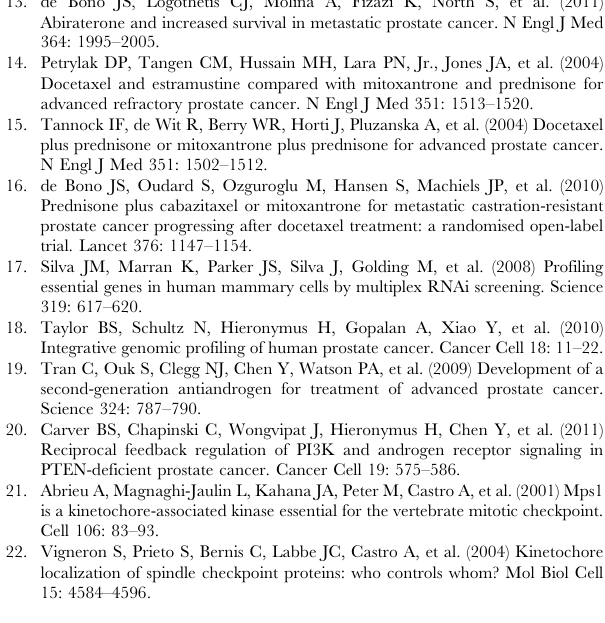
Table S1 Correlation among replicate experiments. Correlation between biological replicate microarray experiments in the LNCaP and PC3 cells 48 h after infection or after culture for 8 or 21 days in vehicle or bicalutamide. For the correlation Table S2 Probes depleted in bicalutamide-treated PC3 cells. The number of microarray probes that had a log2 value Table S3 Tumor TTK expression correlation with clinical characteristics. TTK expression in 131 prostate tumors and its correlation with surgical margin, lymph node status, seminal vesicle, Gleason score, treatment prostate specific antigen (PSA), mean PSA, or extracapsular extension. TTK overexpressed samples were defined as z-score $ 2 and TTK not overexpressed samples were defined as z-score , 2. Table S4 Primers used for quantitative reverse tran- scription-PCR. Primers were used for validation of the mRNA expression levels of the genes defined in Table